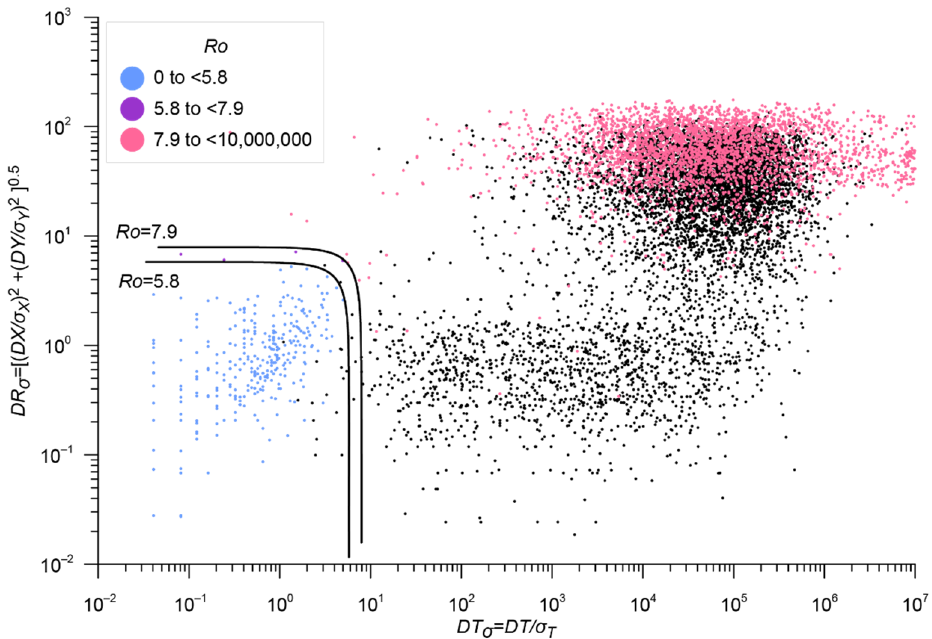
Figure 5. Distribution of normalized DT and DR and metric level lines (1). The colored dots are YAK/NER pairs and the black dots are the distances between YAK/YAK events in metric (1). The metric levels Ro = 5.8 and Ro = 7.9 are shown by black lines, and absolute duplicates are not shown.